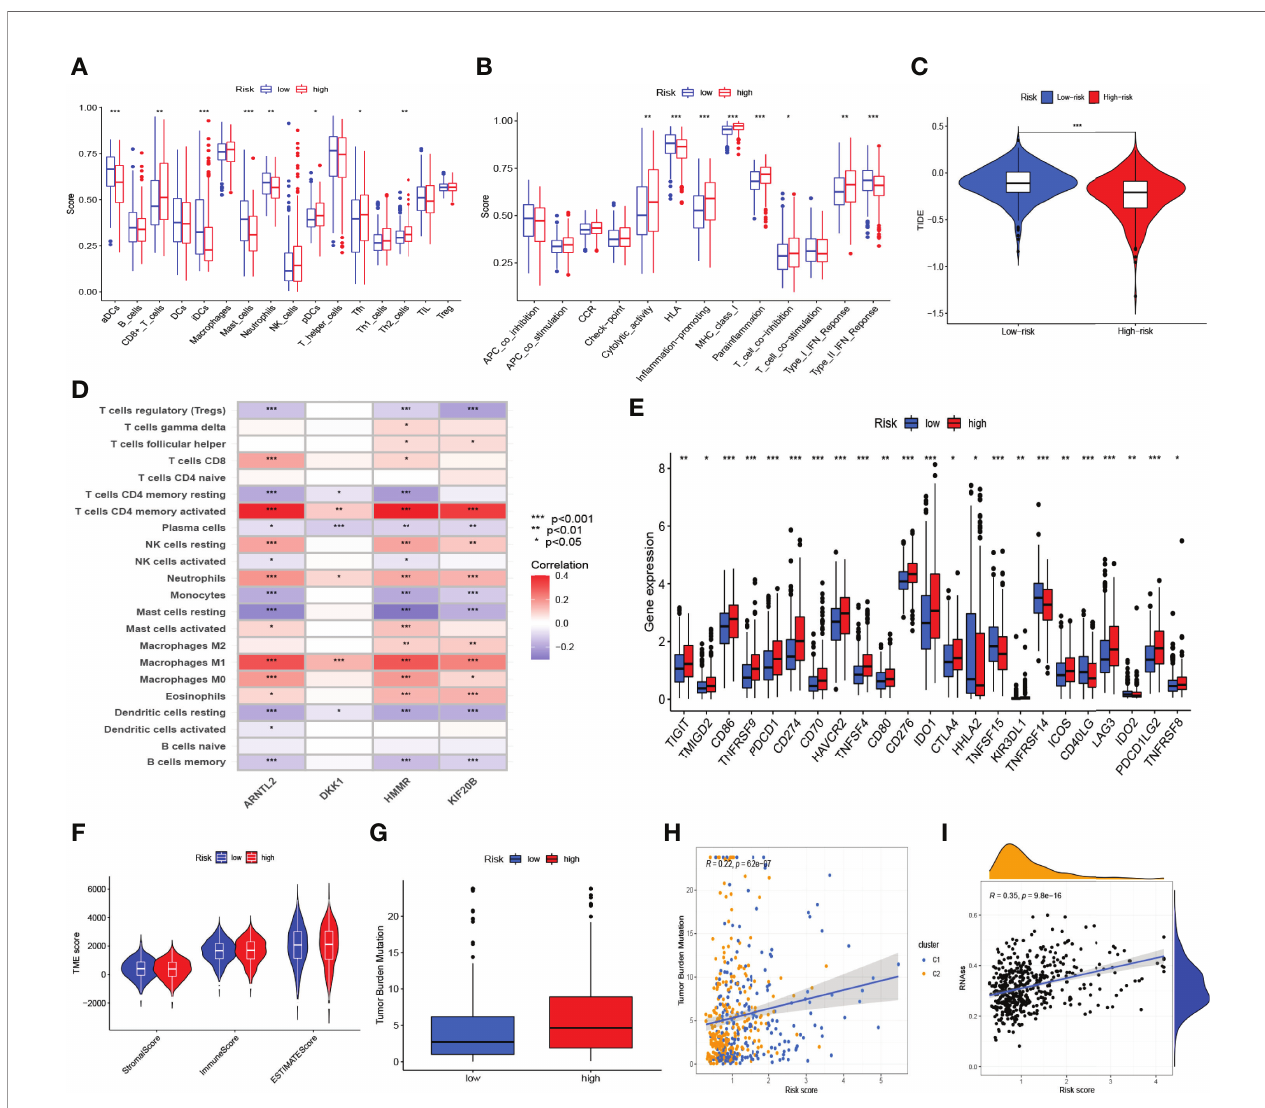
FIGURE 7 | Risk signature-based immune cell in fi ltration, immune-related pathways, tumor microenvironment (TME), and stemness analyses. The differences in the scores of immune cells (A) and immune functions (B) in the training cohort. (C) The differences in tumor immune dysfunction and exclusion (TIDE) score in The Cancer Genome Atlas-lung adenocarcinoma cohort. (D) The correlations of immune cell in fi ltration and the four genes in the risk model in a combined lung adenocarcinoma (LUAD) dataset of the TCGA and GSE68465 cohorts. (E) The differentially expressed immune checkpoint-related genes between the high- and low- risk groups. (F) ESTIMATE, immune, and stromal scores between the high- and low-risk groups in the combined LUAD dataset. (G) The difference in tumor mutation burden (TMB) between the high- and low-risk groups in the combined LUAD dataset. Spearman ’ s correlation analyses between the risk score and TMB (H) , as well as between the risk score and mRNAsi scores (RNAss) (I) in the combined LUAD dataset. * p < 0.05, ** p < 0.01, *** p < 0.001.